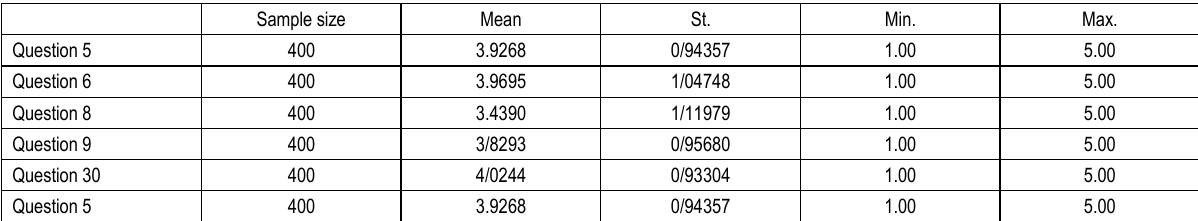
Table 16. Results of descriptive statistics (sympathy factors)